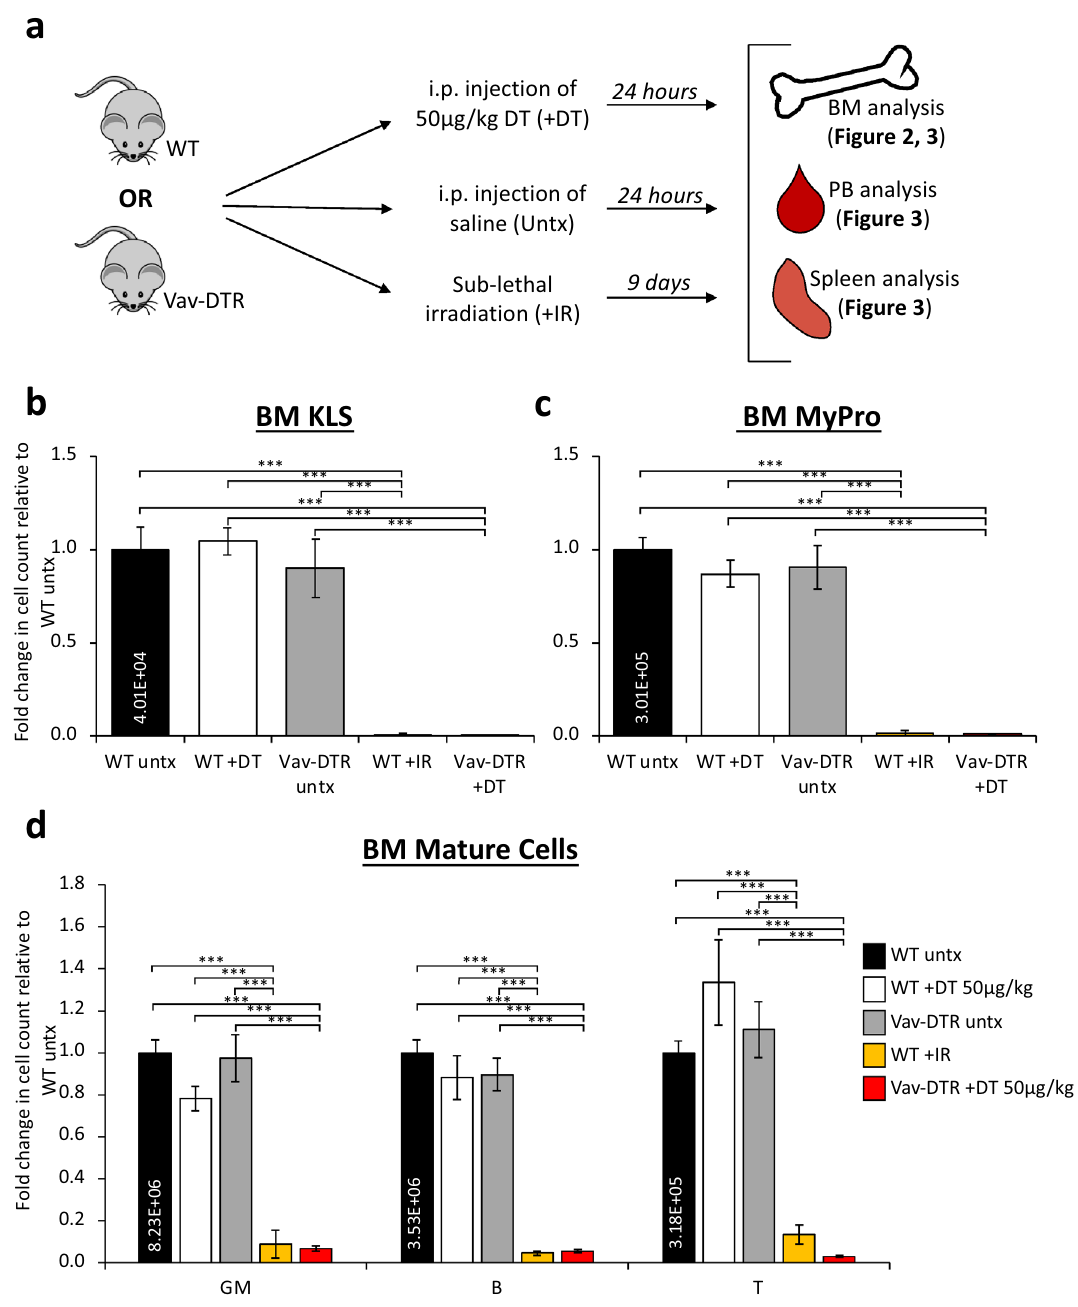
Figure 2. HSPCs and mature cells from the BM of Vav-DTR mice are depleted by DT in vivo. ( a ) Schematic of experimental design. WT and Vav-DTR mice received an i.p. injection of 50 µg/kg of DT 24 h prior to takedown for BM, PB, and spleen analysis. These data were compared to WT and Vav-DTR mice treated with a control saline injection (untreated), and WT mice that were sub-lethally irradiated 9 days prior to takedown. DT depleted KLS ( b ), MyPro ( c ) and mature blood cells ( d ) in the BM of Vav-DTR mice (red bar), similar to 9-days post sublethal (750 rads) irradiation (IR, yellow bar; positive control). WT mice were unaffected by DT treatment (white bars), harboring similar cell numbers to untreated WT mice (black bar; negative control), and untreated Vav-DTR mice (gray bars). The numbers in the black bar represent absolute cell count in the BM. Bar graphs indicate the fold change in cell number relative to untreated WT mice. N = 4–9 mice in at least three independent experiments. Error bars indicate SEM, ***p < 0.001 (One-way ANOVA with Tukey post-hoc test). HSPCs hematopoietic stem and progenitor cells, i.p . intraperitoneal, PB peripheral blood, Untx untreated, IR